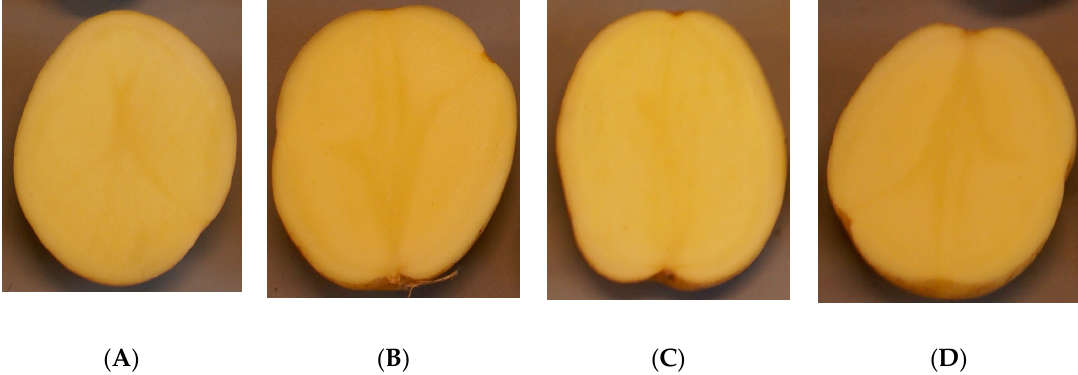
Figure 5. Shades of color brightness of raw tuber flesh cv. ‘Tajfun’ depending on cultivation practices. ( A )—3 applications of fungicide, ( B )—3 applications, ( C )—5 applications, and ( D )—8 applications of effective organisms (EmFarmaTM plus Ema5TM).